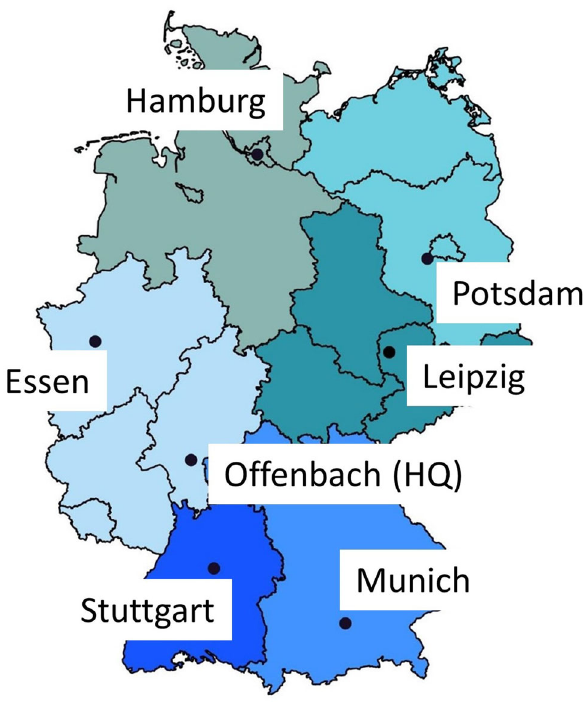
Fig. 1 Schematic map of the German national weather service (Deutscher Wetterdienst, DWD) regional offices in